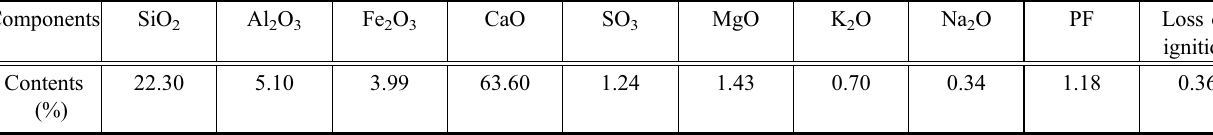
Table 2 Chemical composition of Portland cement.